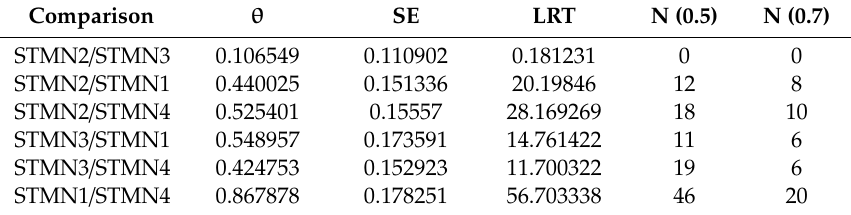
Table 1. Type I functional divergence estimated in fish stathmin paralogs.